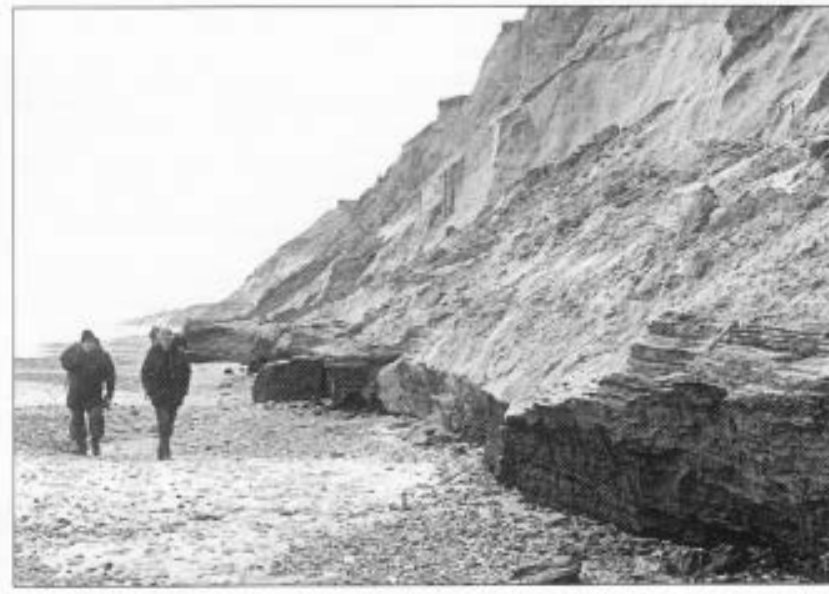
Figure 1 View of the cliff at Pakefield south of Lowestoft on the Suffolk coast, showing dark Forest-bed sediments at the foot of the cliff, over lain by glacial deposits,